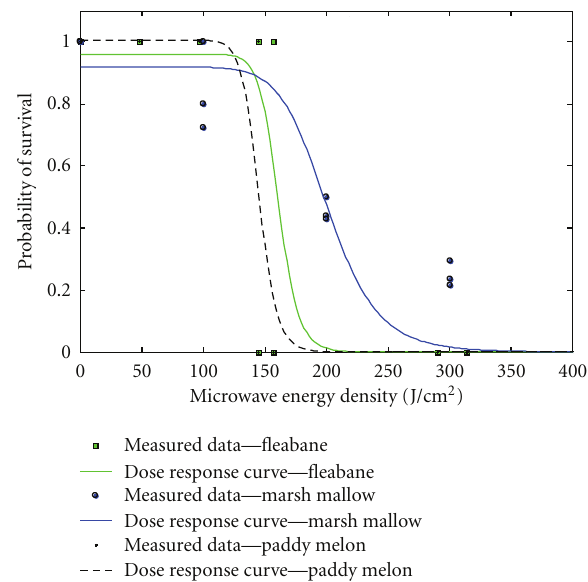
Figure 5: Microwave dose response curves for fleabane, marsh mallow and paddy melon plants.